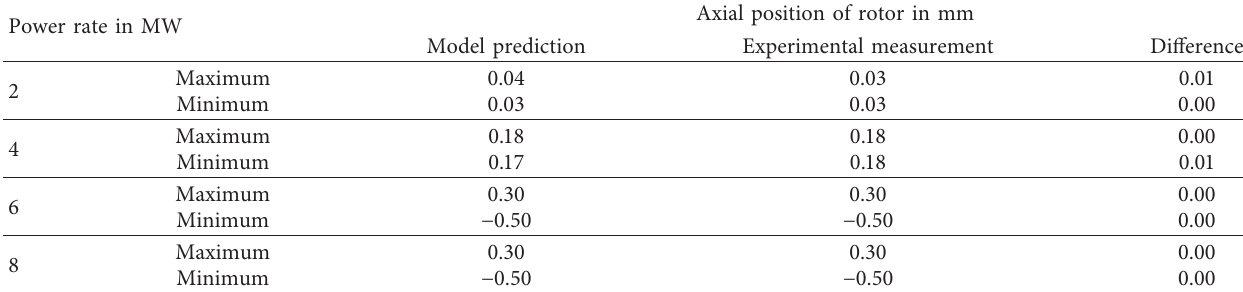
Table 6: Model prediction and experimental measurements, Case